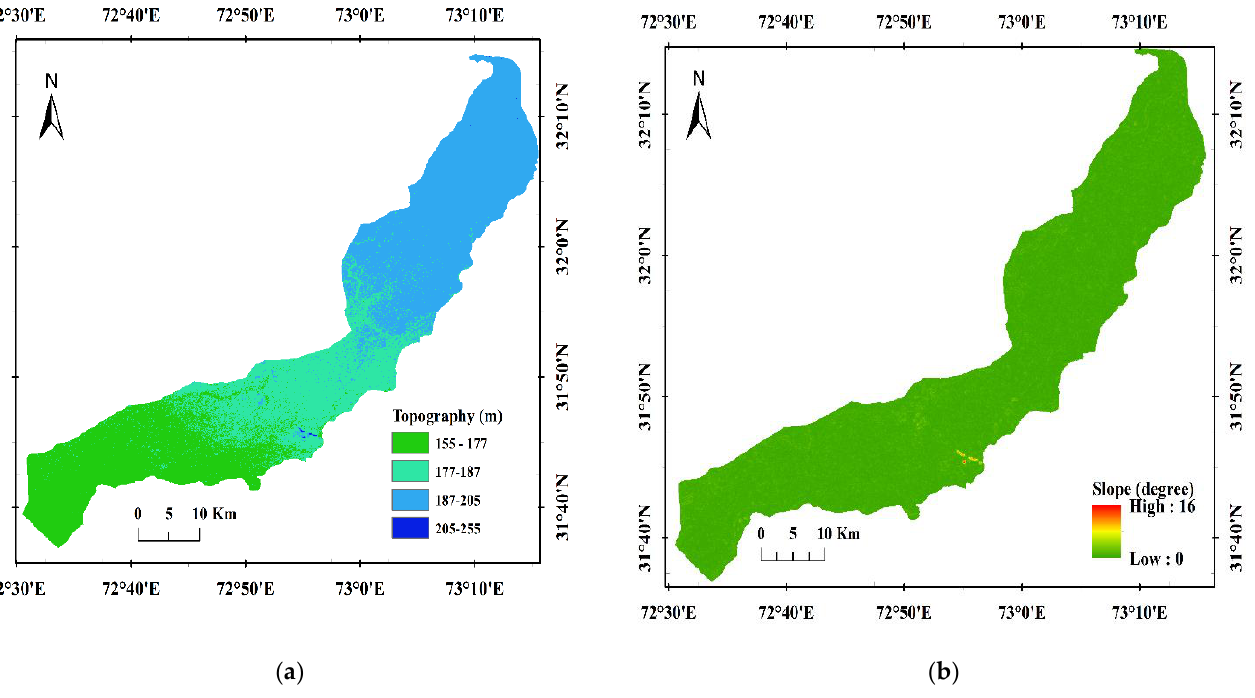
Figure 3. Input maps for model, ( a ) topography, ( b ) slope.